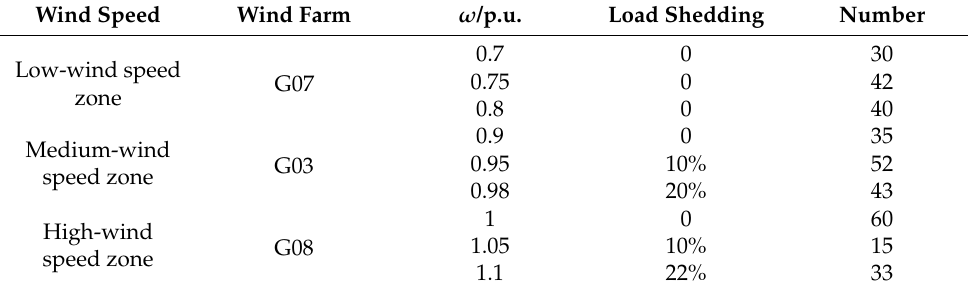
Table 2. Wind turbine speed settings.